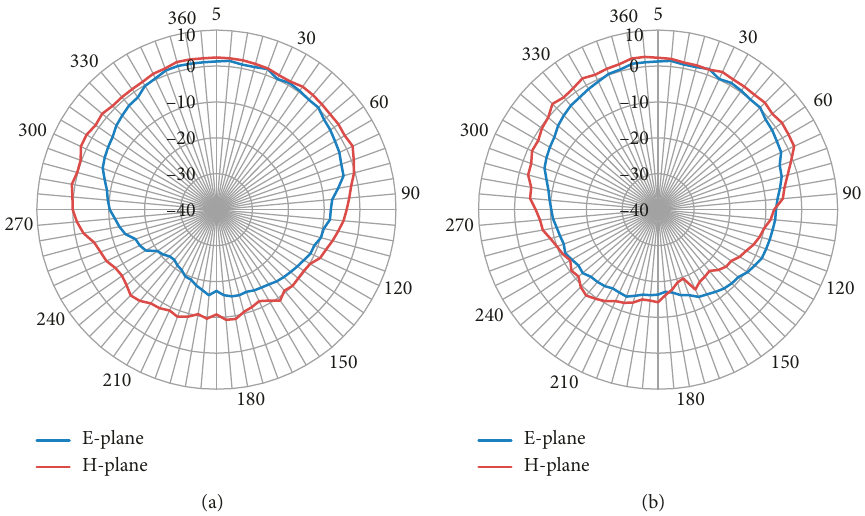
Figure 8: Radiation pattern measured at the minimum axial ratio. (a) LHCP. (b) RHCP.